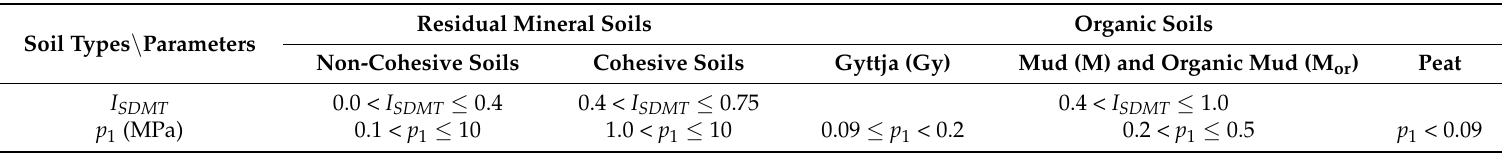
Table 5. Proposed soil classification based on I SDMT and p 1 from in situ (DMT)